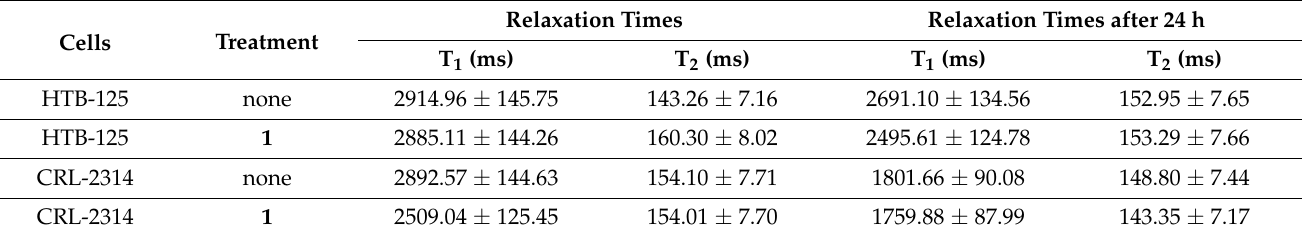
Table 1. Results of T 1 and T 2 relaxation times of two cell lines, CRL-2314 and HTB125, and samples of these lines with the addition of Trastuzumab (1) solution.